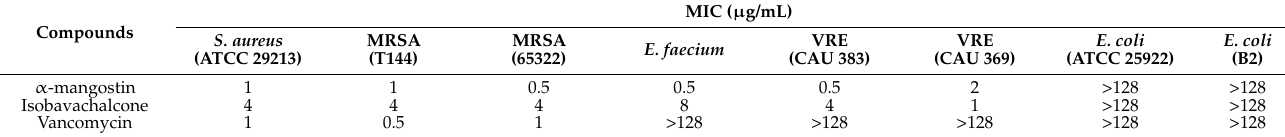
Table 11. Antibacterial activities of isobavachalcone and α -mangostin against multidrug resistant bacterial strains.